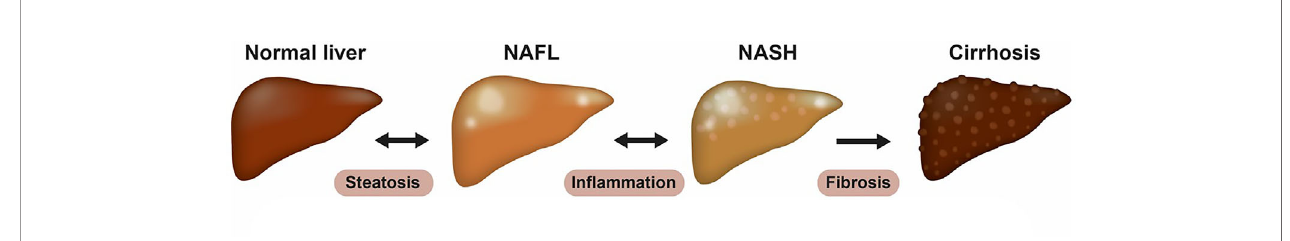
FIGURE 1 | The spectrum of NAFLD. Non-alcoholic fatty liver disease (NAFLD) is a spectrum of diseases, now recognized as the most common liver disease worldwide. It ranges from simple steatosis (NAFL) to non-alcoholic steatohepatitis (NASH), cirrhosis, and its complications. NAFL is de fi ned as the presence of